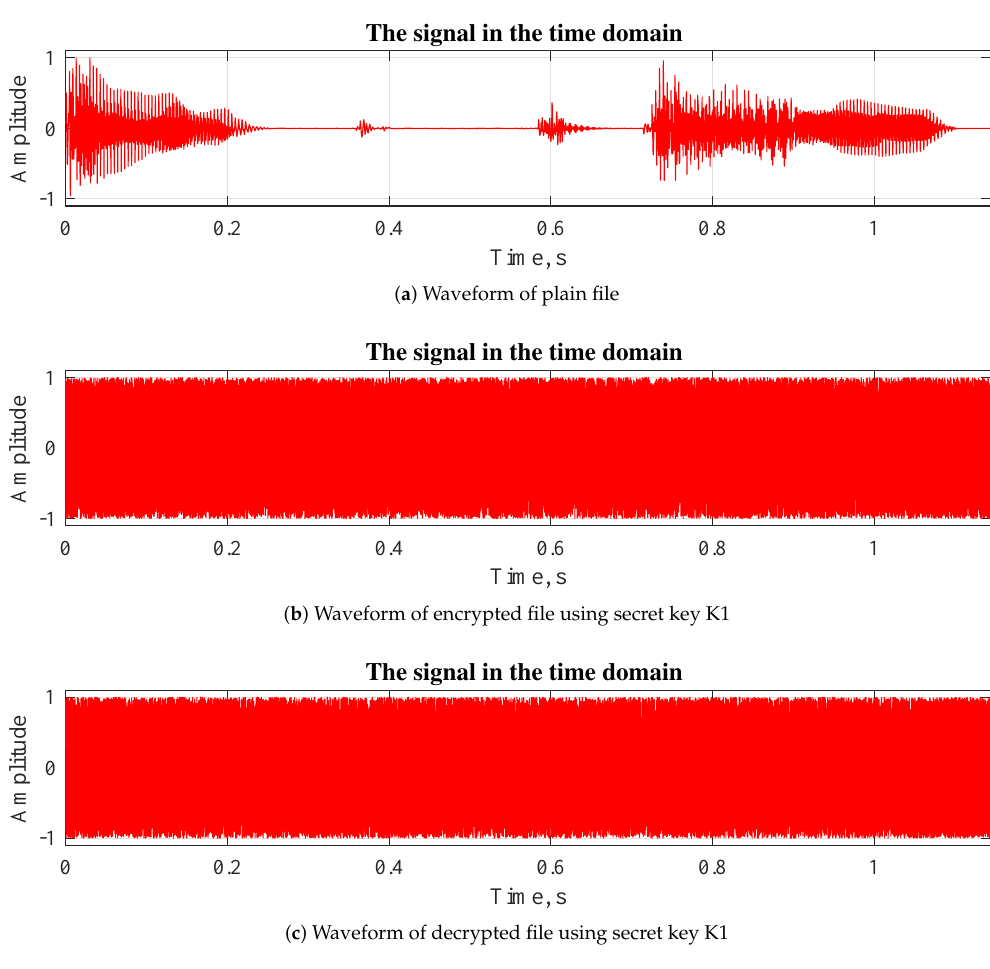
Figure 8. Waveform plotting-key